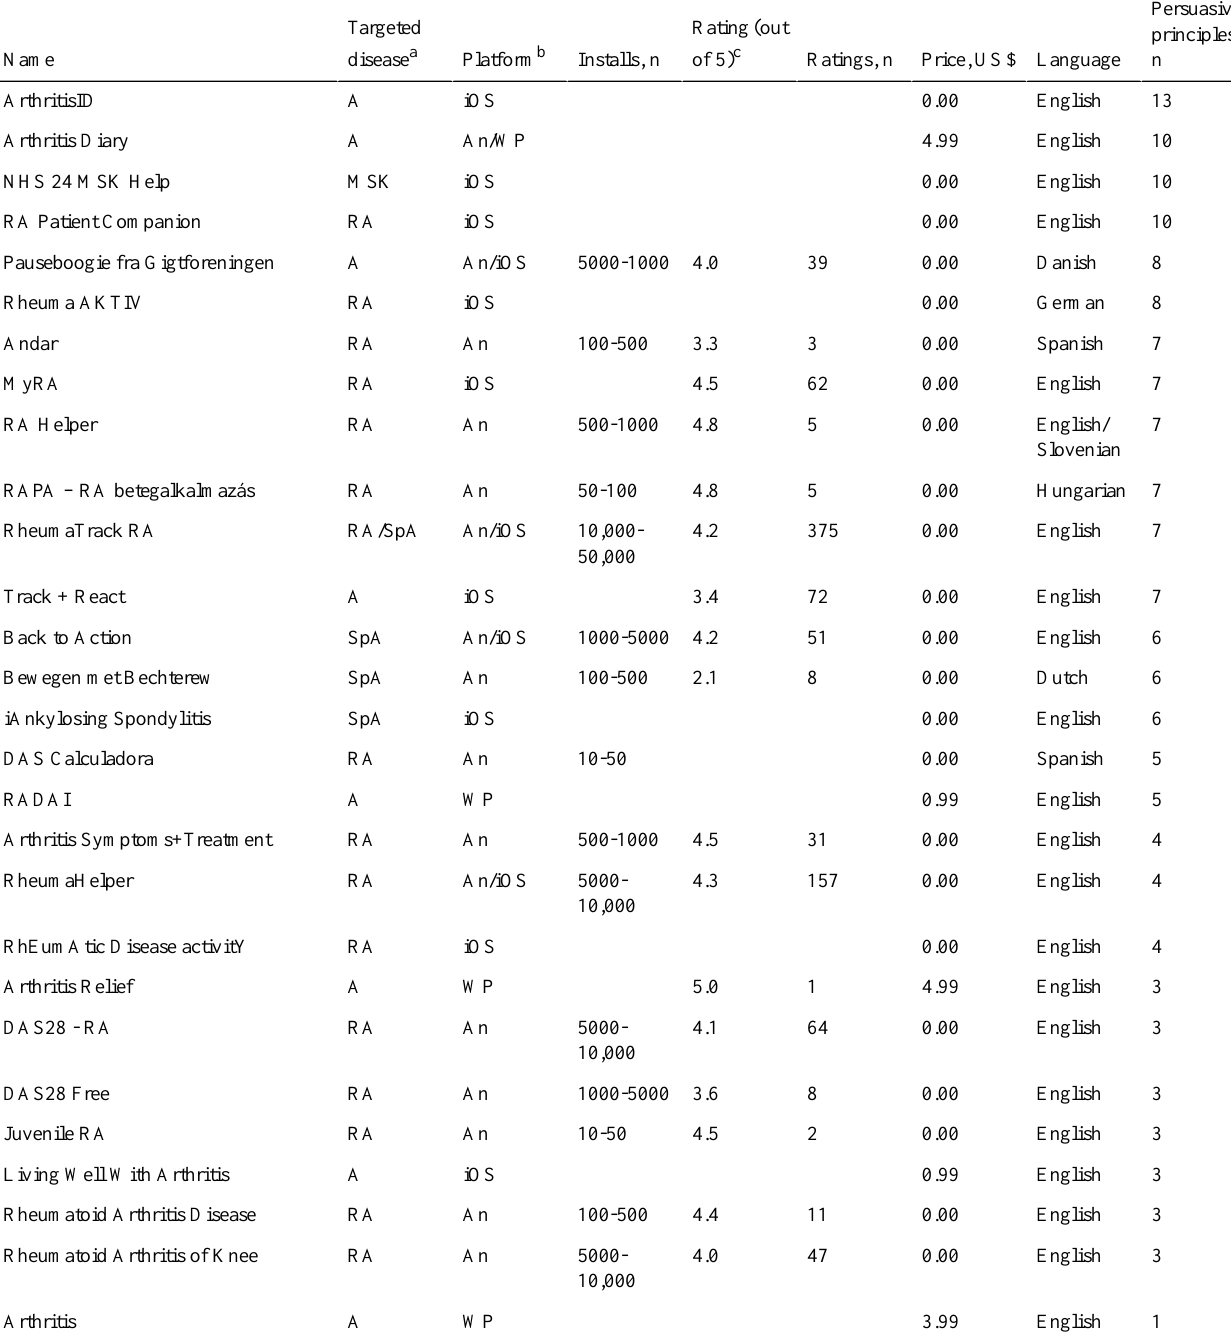
Table 1. Detailed description of the 28 health apps that met the selection criteria.